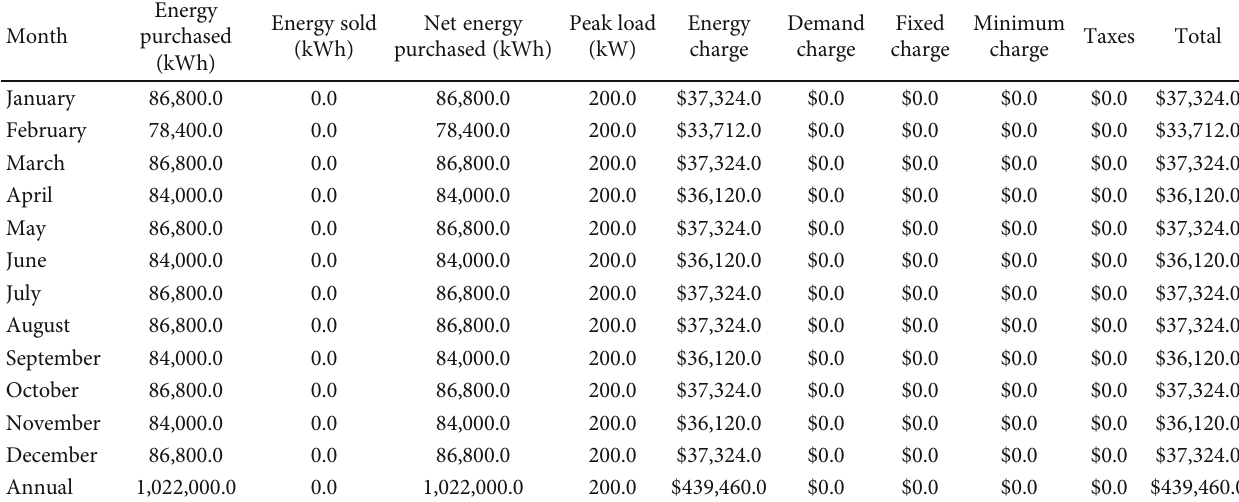
Table 21: Utility monthly summary — current system (South Sudan).